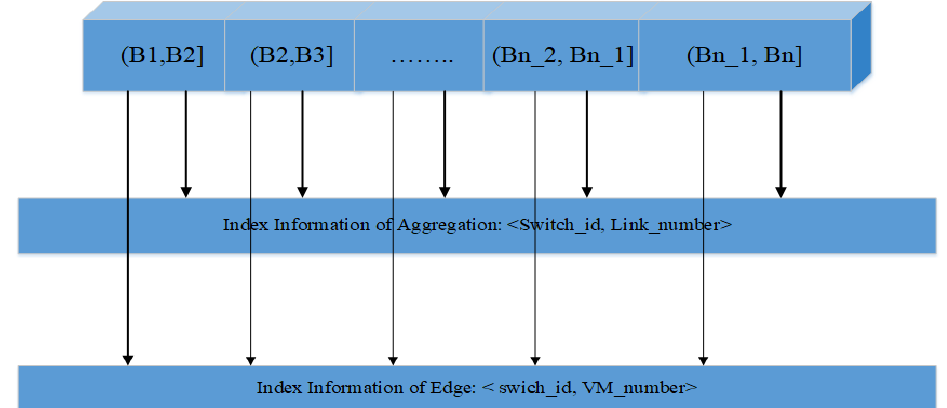
Figure 8. PAM index information.